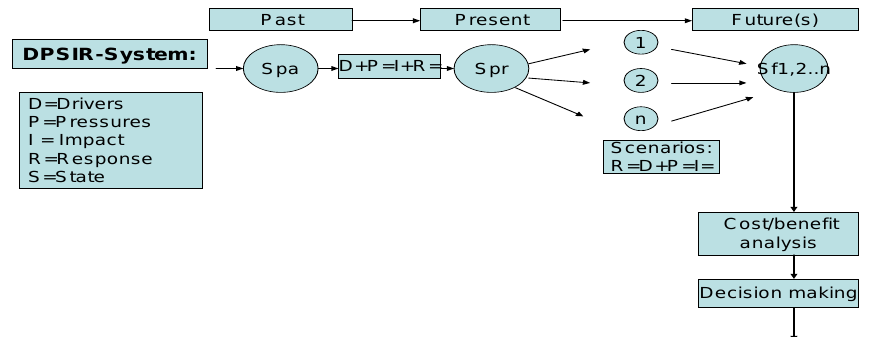
Figure 1. Future land use scenarios (Sf) (derived in consultation with stakeholders, policy makers, and colleague scientists), from which a choice has to be made in the policy arena. Which one represents sustainable development best? (S: status of the land defined in terms of the seven soil functions) (from Bouma, 2010).